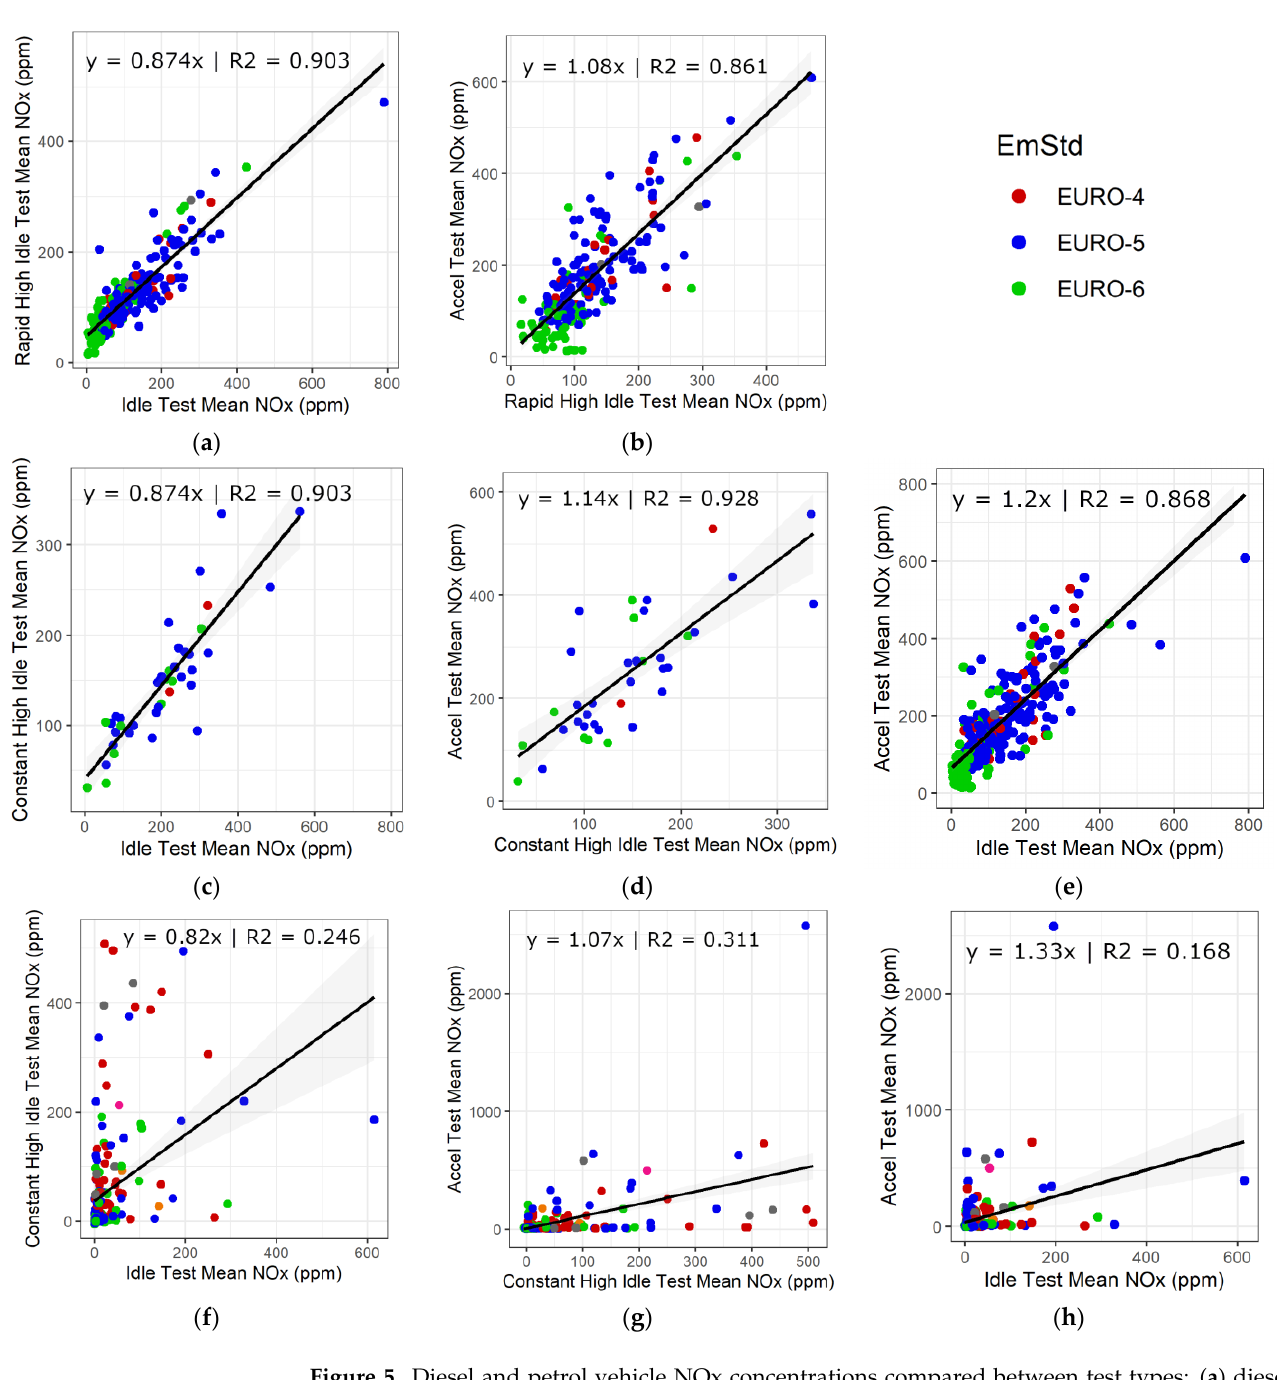
Figure 5. Diesel and petrol vehicle NOx concentrations compared between test types: ( a ) diesel vehicle rapid high idle test mean NOx versus idle test mean NOx; ( b ) diesel vehicle rapid high idle test mean NOx versus acceleration test mean NOx; ( c ) diesel vehicle constant high idle test mean NOx versus idle test mean NOx; ( d ) diesel vehicle constant high idle test mean NOx versus acceleration test mean NOx; ( e ) diesel vehicle acceleration test mean NOx versus idle test mean NOx; ( f ) petrol vehicle constant high idle test mean NOx versus mean idle test NOx; ( g ) petrol vehicle constant high idle test mean NOx versus acceleration test mean NOx; ( h ) petrol vehicle acceleration test mean NOx versus idle test mean NOx.